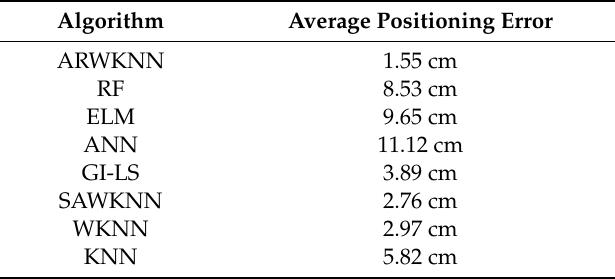
Table 3. Average positioning error for each algorithm with SNR = 20